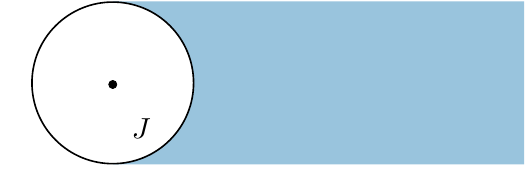
Figure 5. Wake region from actuator cylinder theory highlighted in blue (and extending